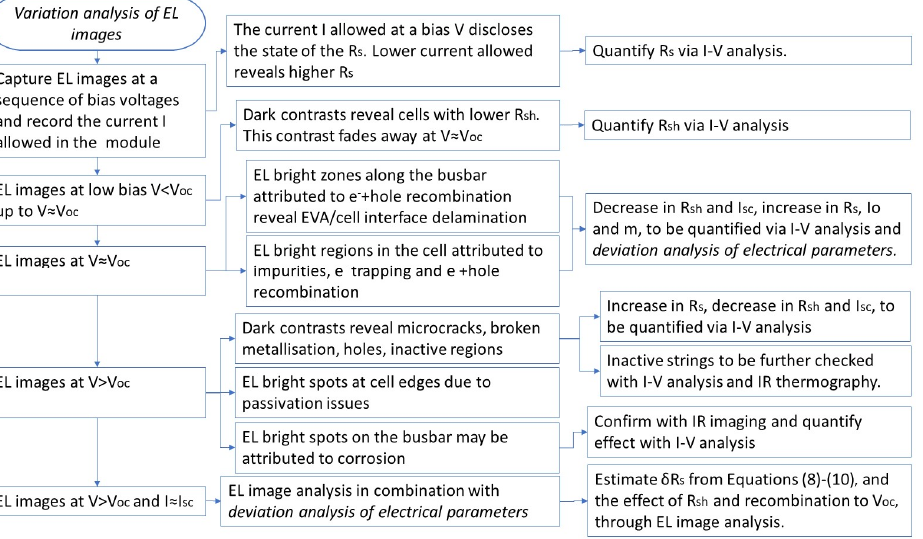
Figure 16. Functional flow-block diagram illustrating the variation analysis of EL images at various bias-voltages and the synergies with other NDT techniques.